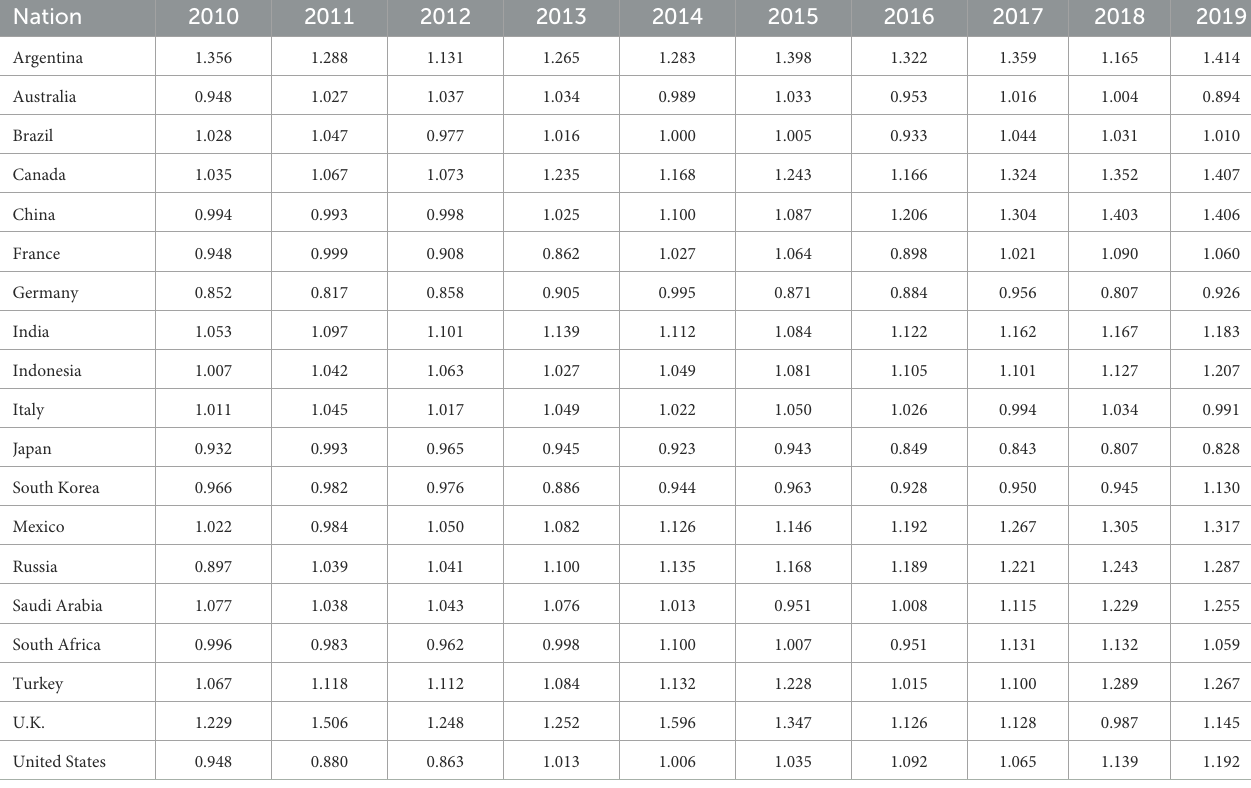
TABLE 2 Agricultural TFP of G20 countries from 2010 to 2019. Nation